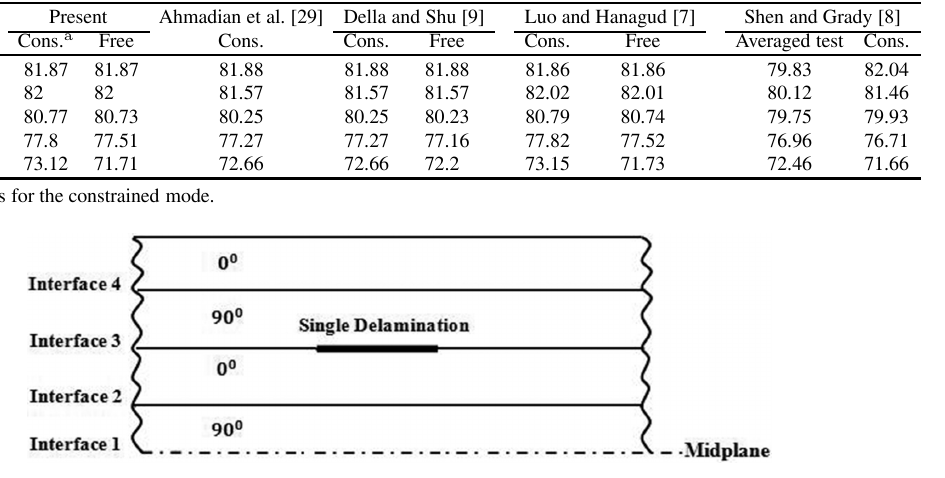
Table 1 Fundamental frequencies (Hz) of the beam with single delamination located at interface 3